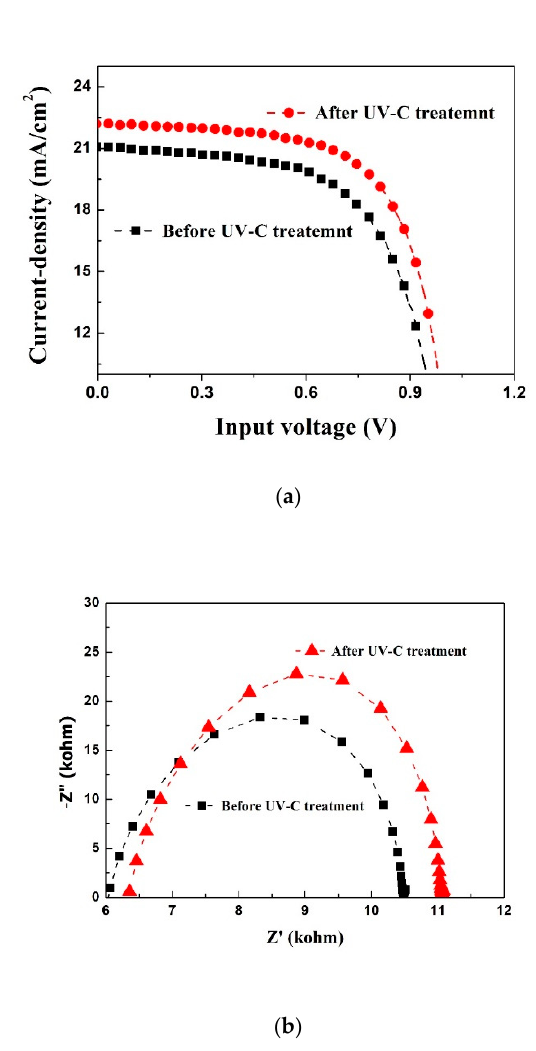
Figure 8. Photovoltaic properties of perovskite solar cells (PSCs) before and after UV treatment; ( a ) current–density and ( b ) Nyquist plots of PSC device. The size of the box plot interquartile is the third quartile (Q3) to the first quartile (Q1).